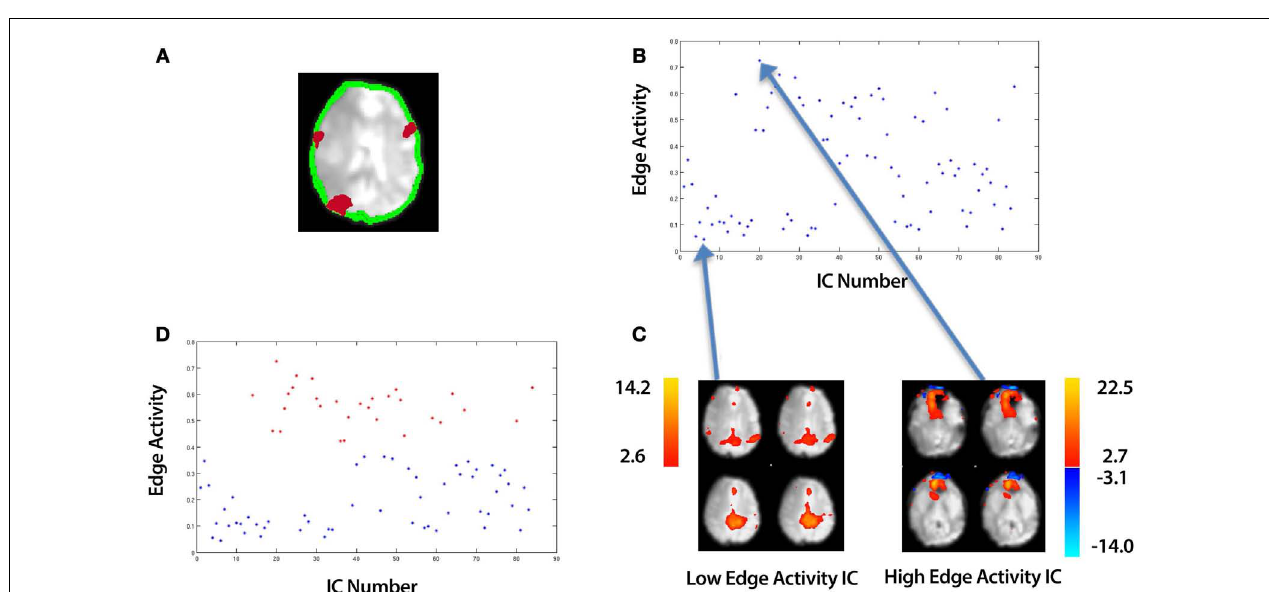
spatial map of the top and bottom points corresponding to the highest and lowest edge activity ICs respectively. (D) Using k-means clustering, the ICs are automatically divided into a set of “High Edge Activity” components (points colored red in the scatter-plot) and “Low Edge Activity” components (points colored blue in the scatter-plot). Each point in the scatter-plot represents the edge activity for a particular IC summed over all